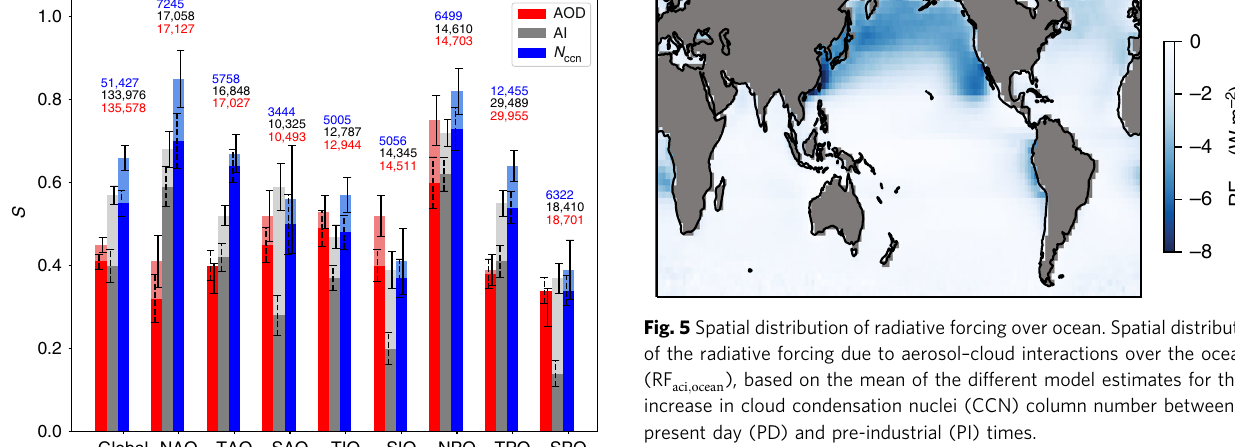
Fig. 3 Dependence of cloud droplet number concentration on aerosol. Cloud droplet number concentration ( N aerosol index (AI), and cloud condensation nuclei (CCN) column number ( N of N and CCN proxy, where each bin contains the same number of points ( n points/20). The colors indicate the normalized histogram of N d -bin. The dashed lines show the linear regression through all data points and the solid lines using only data points for N AI/ N ccn AOD > 0.07, leaving out the lowest 15% of data for all 3 proxies. The quoted errors are 2 σ errors on the regression